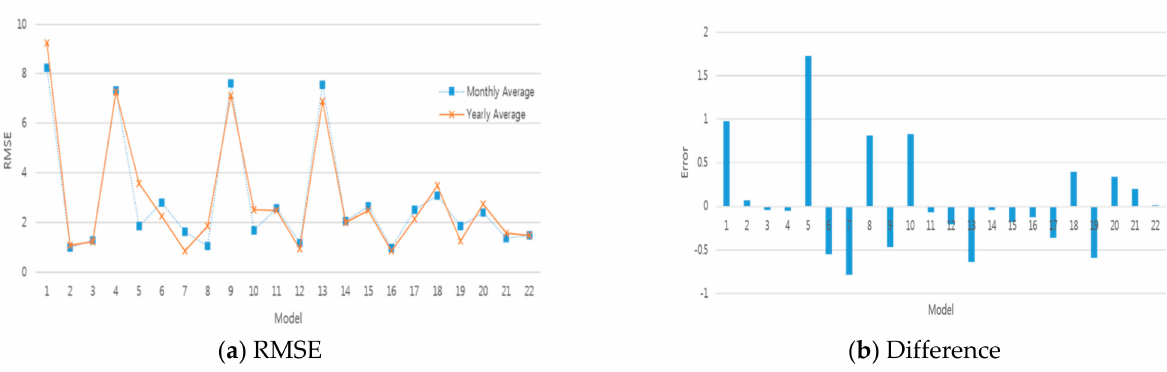
Figure 12. Comparisons between the monthly and yearly averages according to the RMSE values and differences determined by the models.